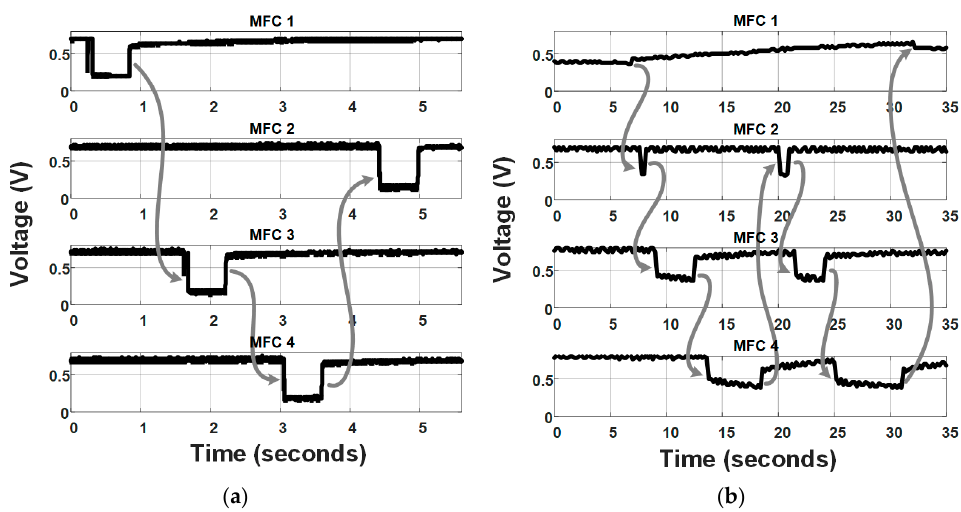
Figure 9. MFC interleaved power extraction measurements: ( a ) Phase one and ( b ) phase two.